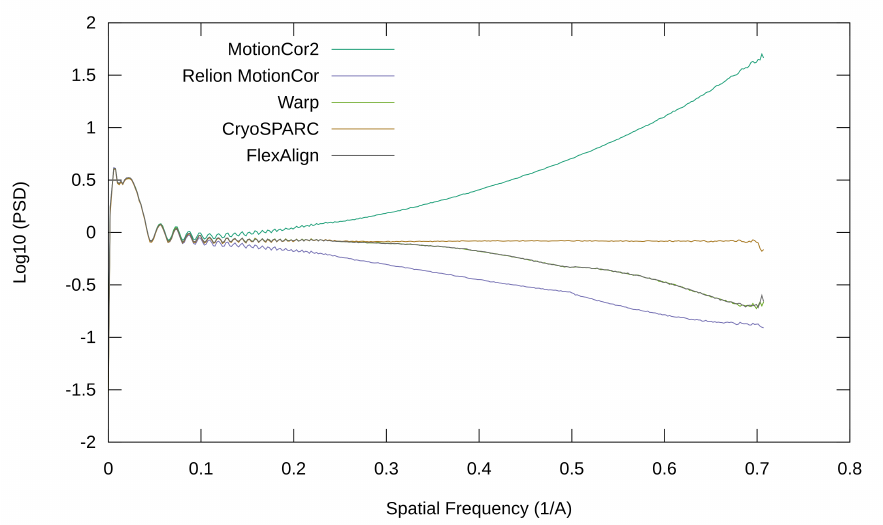
Figure 10. Radial average of the PSD of the produced micrograph using EMPIAR